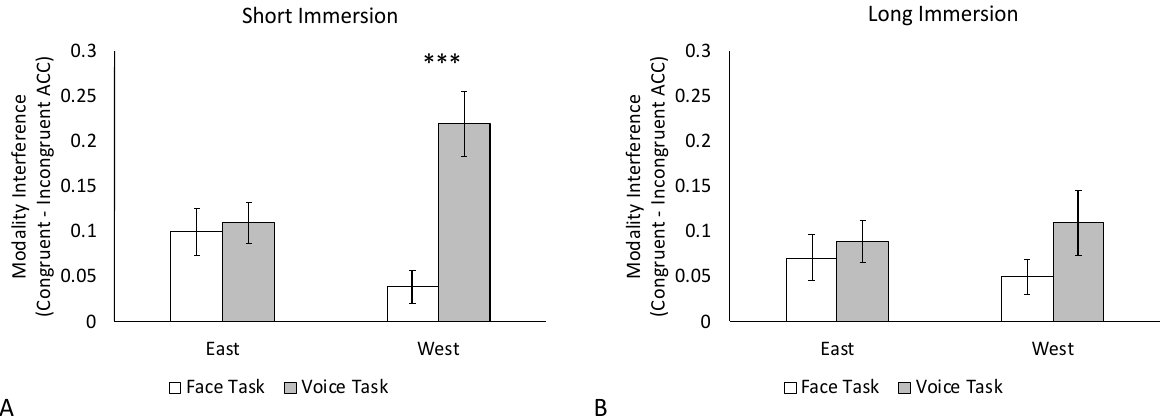
Figure 3. Modality interference effects in accuracy rates (bimodal congruent trials minus bimodal incongruent trials) for Chinese-English bilinguals immersed in North America for a short duration ( A ) and long duration ( B ). The short immersion group showed a larger modality interference in the voice task than the face task for the emotional information from the West (i.e., visual interference). The long immersion group showed no differences between tasks in both cultures. Error bars represent standard error. *** p < 0.001.